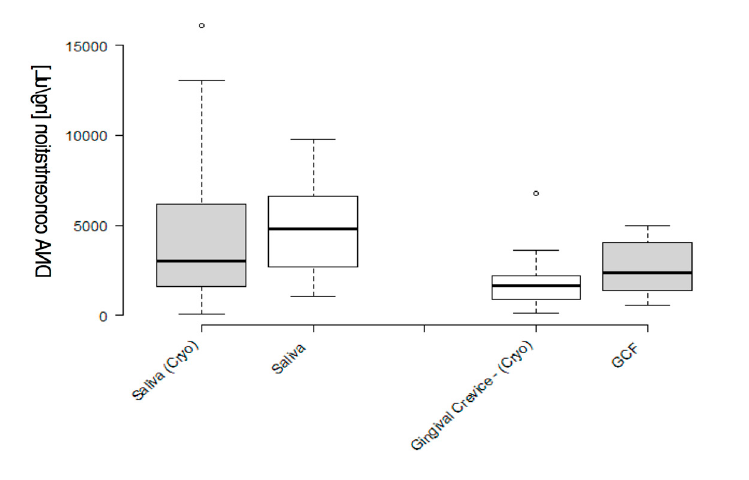
Figure 2. Comparison of DNA concentrations isolated from the frozen and original (fresh) saliva samples. A box-and-whisker plot analysis of data demonstrates a broader range of DNA concentrations among frozen samples when compared with fresh samples, with roughly similar averages (4264.1 ng / µ L and 4809.3 ng / µ L, p = 0.5389), and gingival crevicular fluid (1762 ng / µ L and 2639.5 ng / µ L, p =